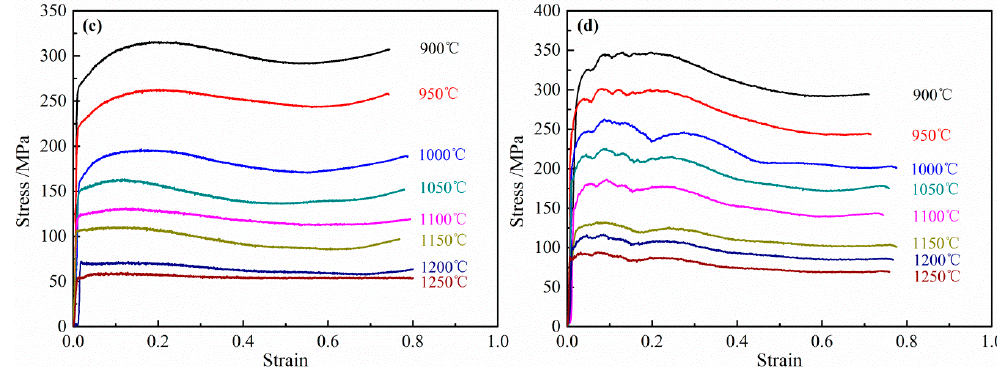
Figure 2. Flow stress vs. strain curves of 2707 HDSS under different strain rates: ( a ) 0.01 s − 1 ; ( b ) 0.1 s − 1 ; ( c ) 1 s − 1 ; ( d ) 10 s − 1 .